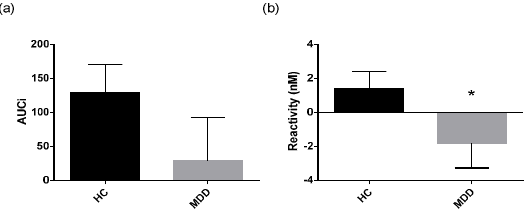
Figure 2. CAR responsivity measures in patients and healthy controls.( a ) area under the curve with respect to increase(AUCi) and ( b ) cortisol awakening response (CAR) reactivity expressed as mean and SEM in depressed patients ( n = 57) and healthy controls (HC) ( n = 41). * p ≤ 0.05 vs. control. (Mann Whitney-U test on log transformed data).